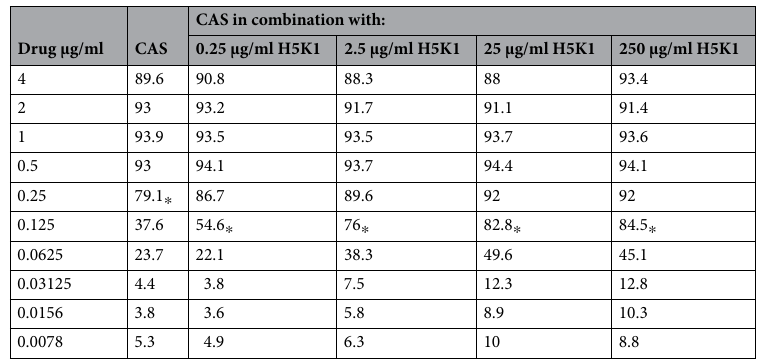
Table 3. Percentage of growth inhibition at 48 h of CAS and CAS in combination with H5K1. The MIC50 breakpoints are marked with *.